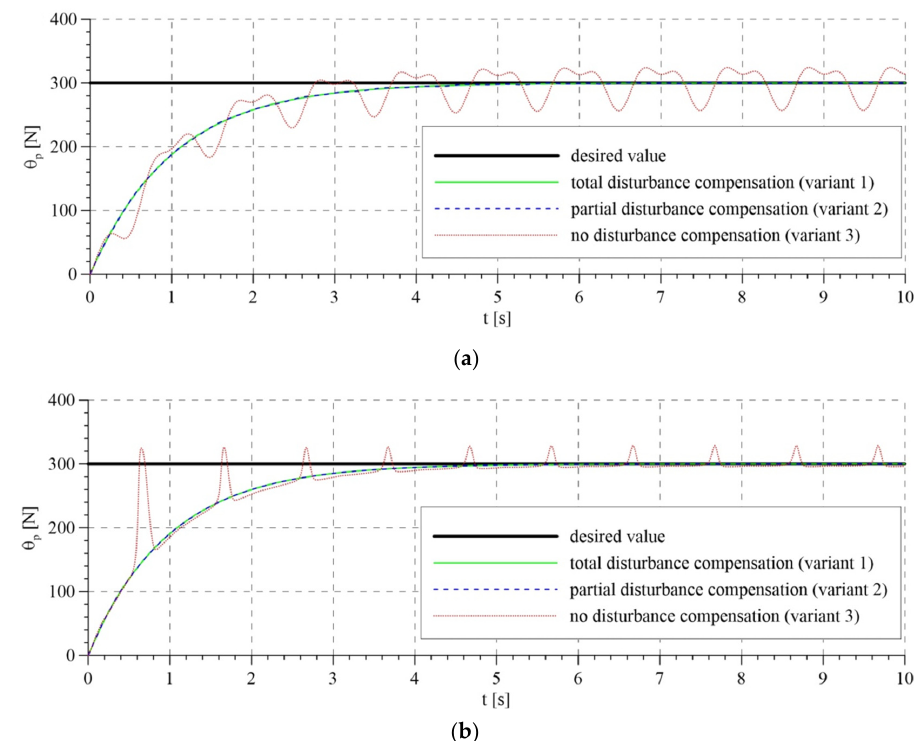
Figure 6. Rope reaction force: ( a ) calculated by the algorithm based on the mathematical model; ( b ) calculated using the adaptive algorithm.